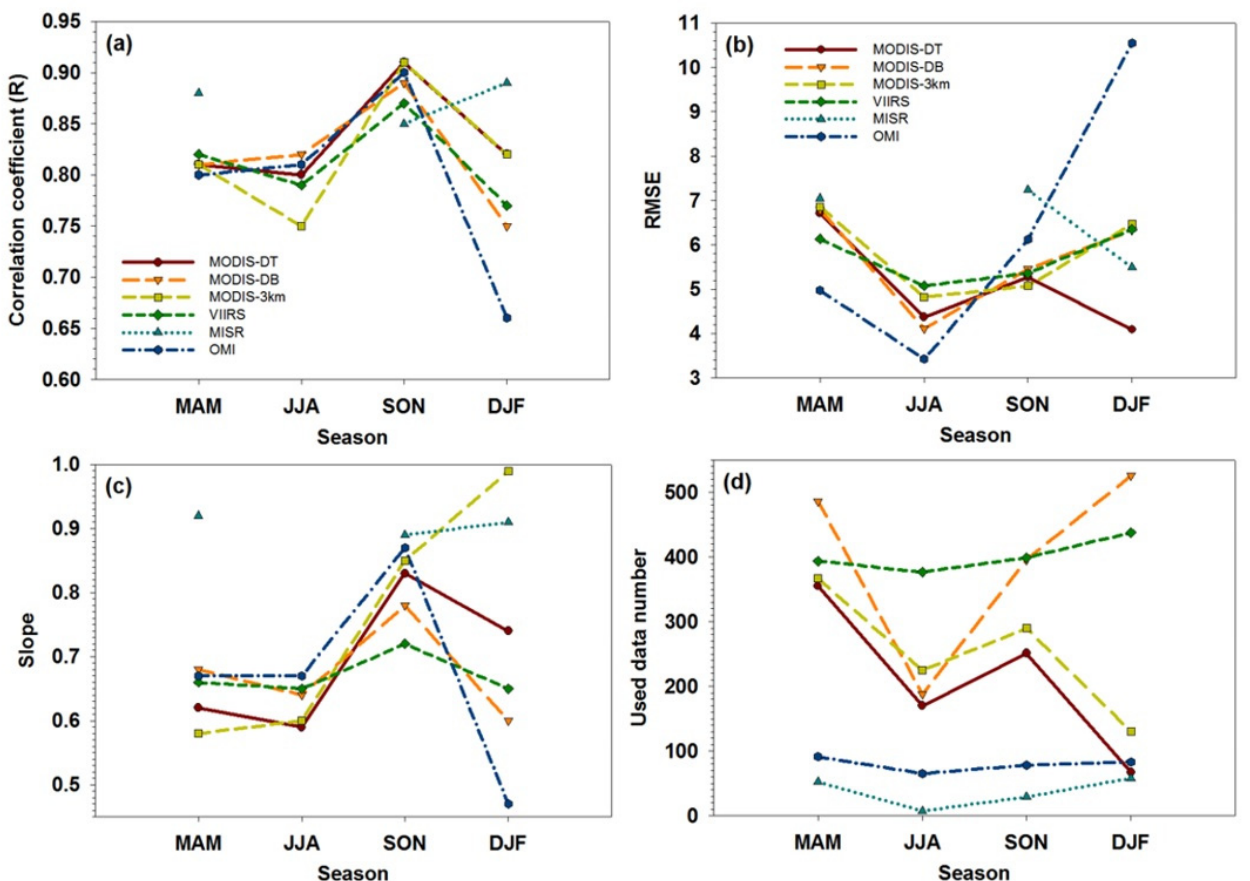
Figure 2. Seasonal variation in ( a ) R, ( b ) RMSE, ( c ) slope, and ( d ) number of data used in correlations between measured and estimated PM 2 . 5 (unit: μ g/m 3 ) values. Estimated PM 2 . 5 values here are from the M3-1 model using MODIS-DT (red), MODIS-DB (orange), MODIS-DT for 3 × 3 km resolution (yellow green), VIIRS (green), MISR (light blue), and OMI (blue)